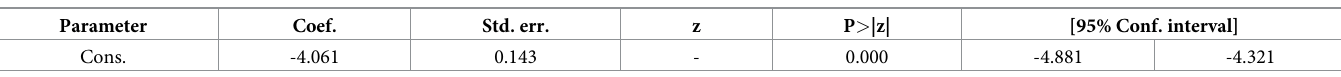
Table 2. The exponential function in the classical model for the excavator’s failure data. Parameter Coef. Cons.